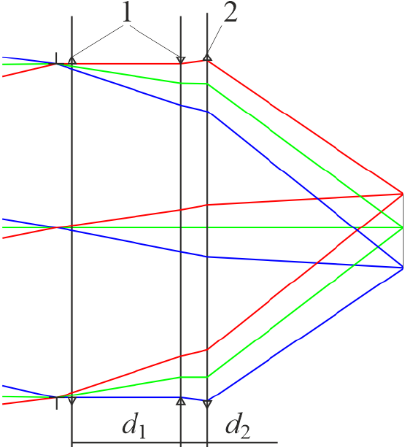
Figure 1. Initial configuration: 1 is aberration corrector; 2 is power component. To minimize the size of the front lens, the entrance pupil or aperture stop should be placed near the top of its first surface. For the aberration correction in the region of monochromatic aberrations for the ultra-high-aperture systems, aplanaticity is of fun- aberrations near the optical